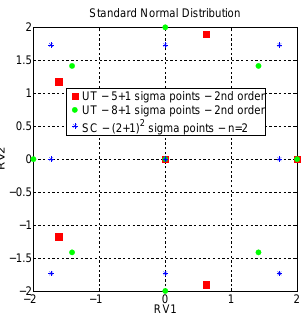
Figure 1: Different sigma points distributions for two RV (UT and SC).